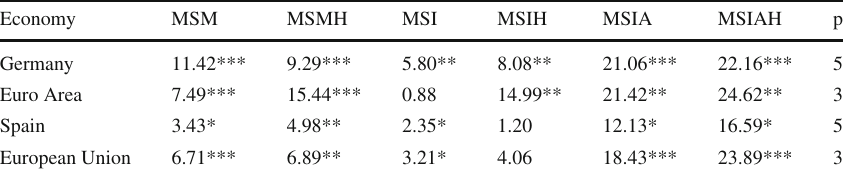
Table 4 Non-linear test. Source: author’s